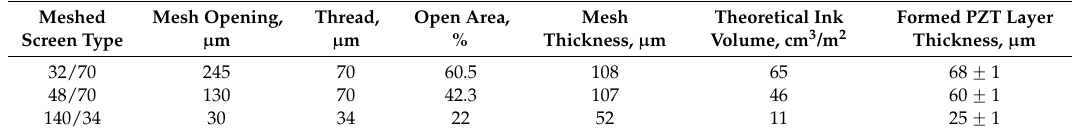
Table 1. Properties of screen mesh and layer thickness.